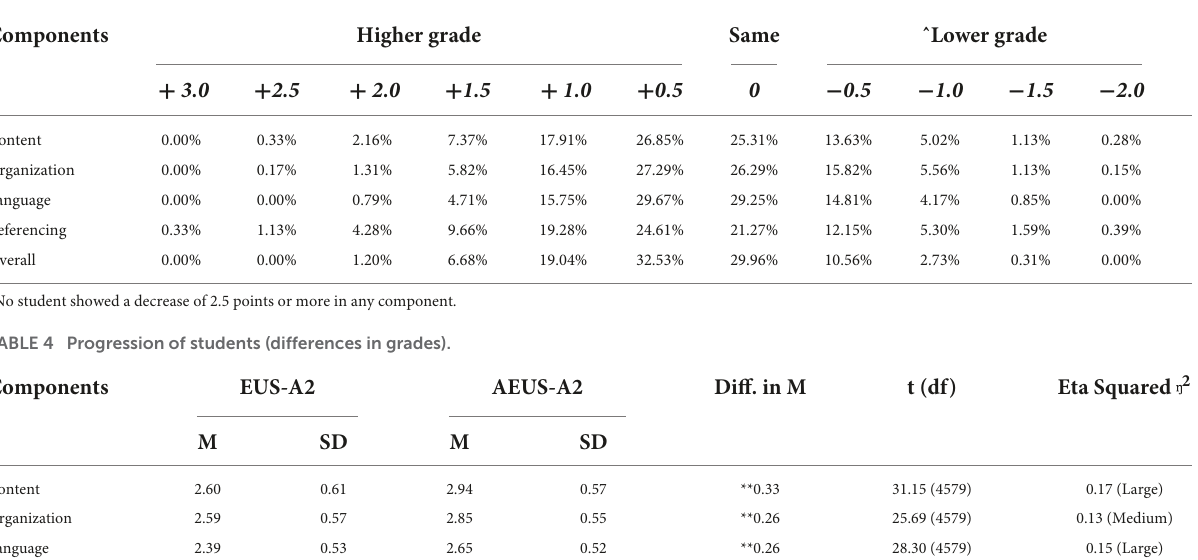
TABLE 3 Progression of students (proportion).